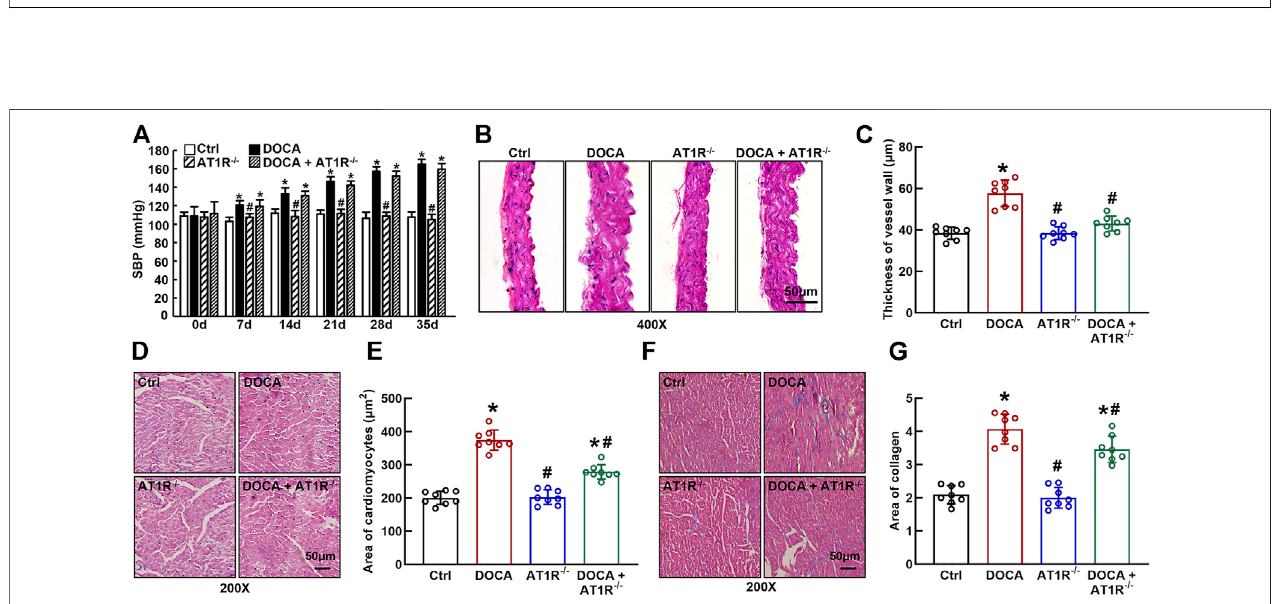
FIGURE 7 | Speci fi c myeloid AT1R KO reduced aortic and cardiac hypertrophy and cardiac fi brosis in DOCA/salt-sensitive hypertensive mice. Speci fi c myeloid AT1R KO did not signi fi cantly affect systolic blood pressure (SBP) in DOCA/salt hypertensive mice (A) ; Representative images of the cross section of the aortic wall (B) and cardiomyocyte sectional area (D) assessed by hematoxylin and eosin staining; quantitative analysis of aortic thickness (C) and cardiomyocyte sectional area (E) ; Representativeimagesofcardiac fi brosisassessedbyMasson-trichromestaining (F) ;Quantitativeassessmentofthepositivecollage-stainingareaintheheart (G) . Statistical comparisons were carried out with two-way ANOVA repeated measurements (A) or two-way ANOVA (B – G) followed by the Tukey post hoc test. Data were expressed as mean ± SEM. N = 8, * p < 0.05 vs. control mice, # p < 0.05 vs. DOCA mice.